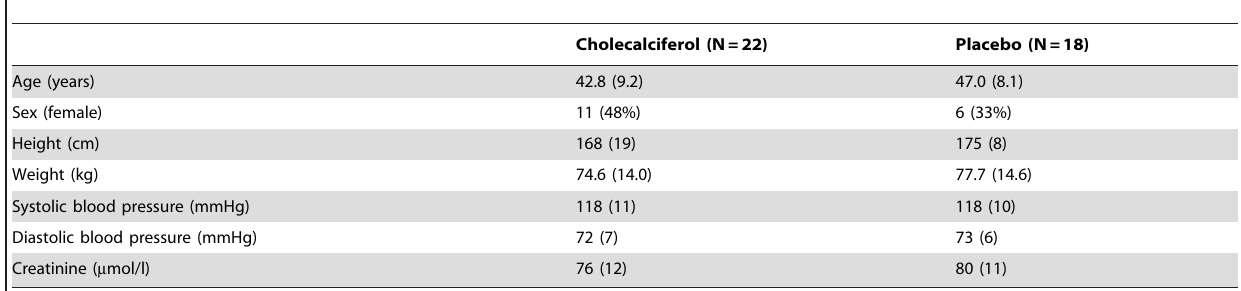
Table 1. Baseline data of participants who completed the